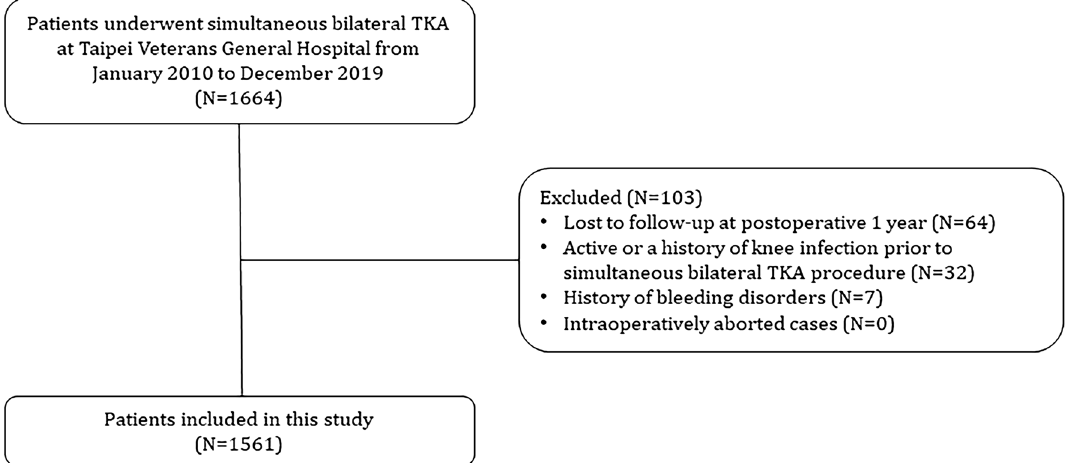
Figure 1. Inclusion flowchart. Abbreviation: TKA, total knee